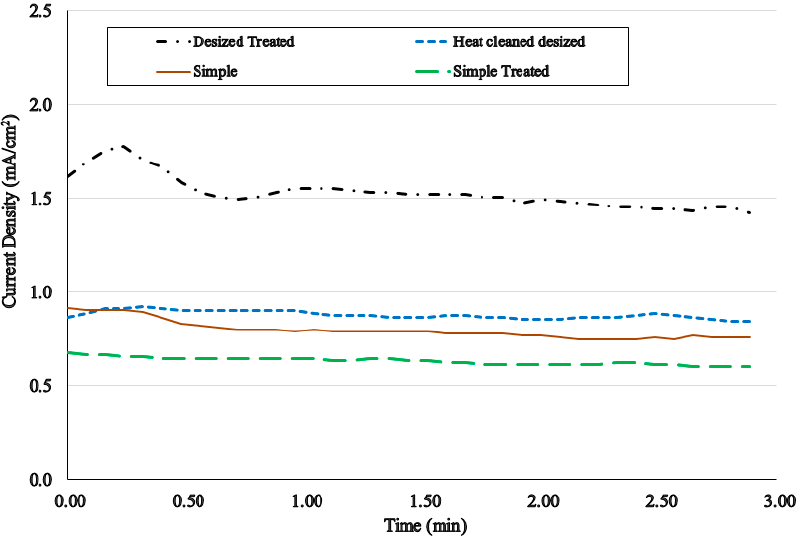
Figure 10. Effect of glass fiber surface specifications on current density of CNT deposition during EPD.